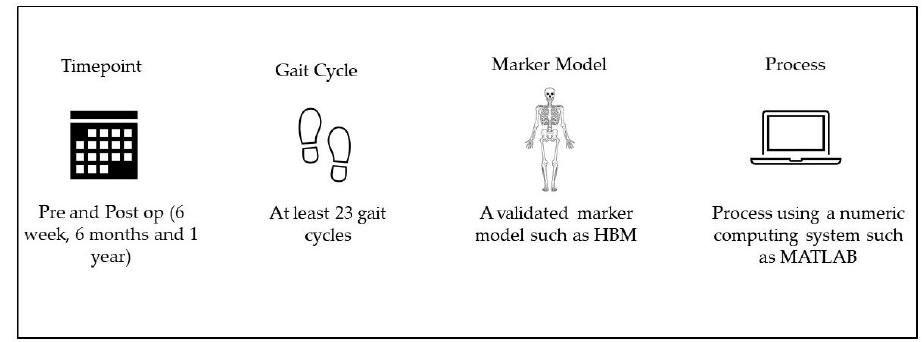
Figure 1. Our recommendations and clinical directions for gait analysis of THR patients.